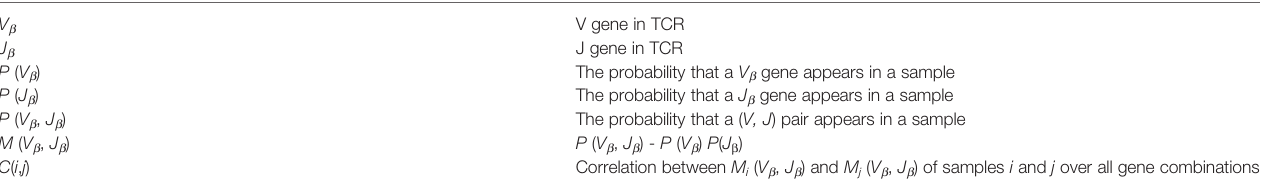
TABLE 1 | Notation.